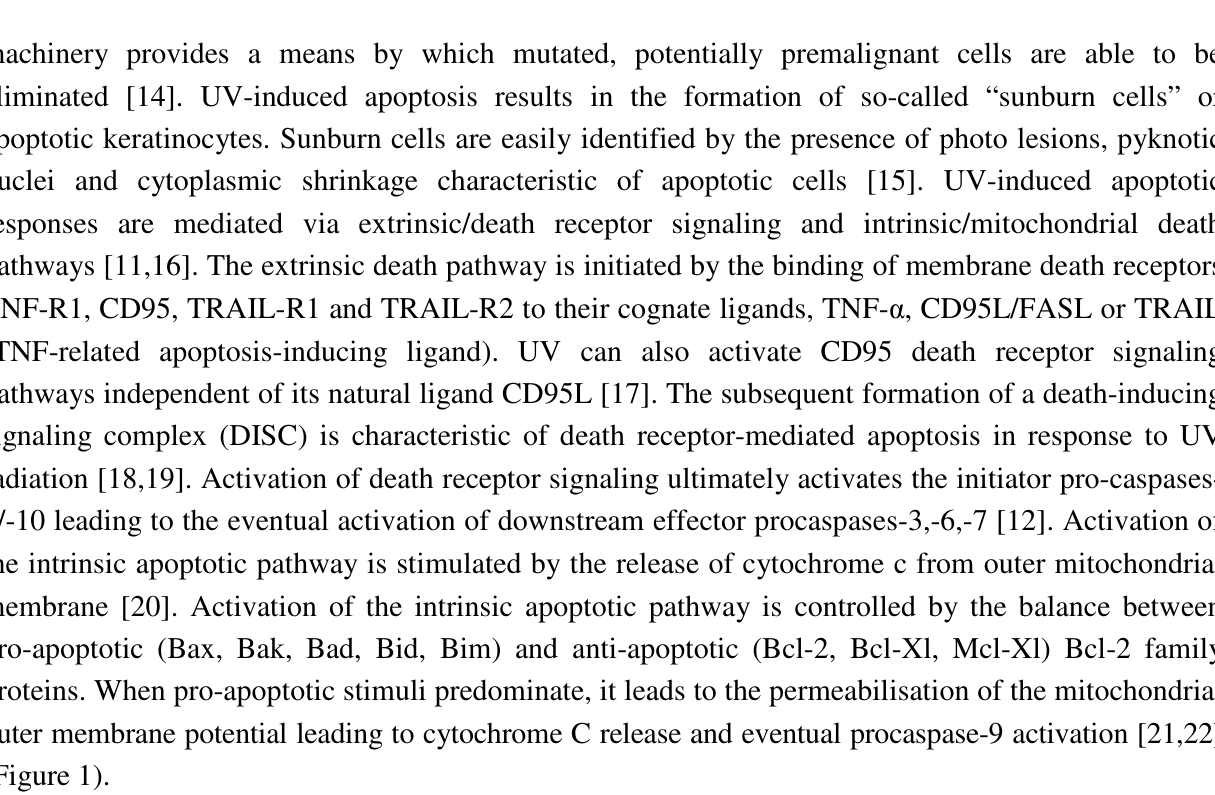
Figure 1. UV-mediated keratinocyte apoptosis can be initiated by extrinsic or intrinsic pathways. Extrinsic pathways include death receptor activation via death ligand binding, DISC formation, activation of pro-caspases and activation of effector caspase-3 leading to apoptosis. Activation of intrinsic pathways induces cytochrome c release from mitochondria and activation of pro-apoptotic Bcl-2 proteins and inhibition of anti-apoptotic Bcl-2 proteins, activation of pro-caspase-9 and activation of effector caspase-3 leading to